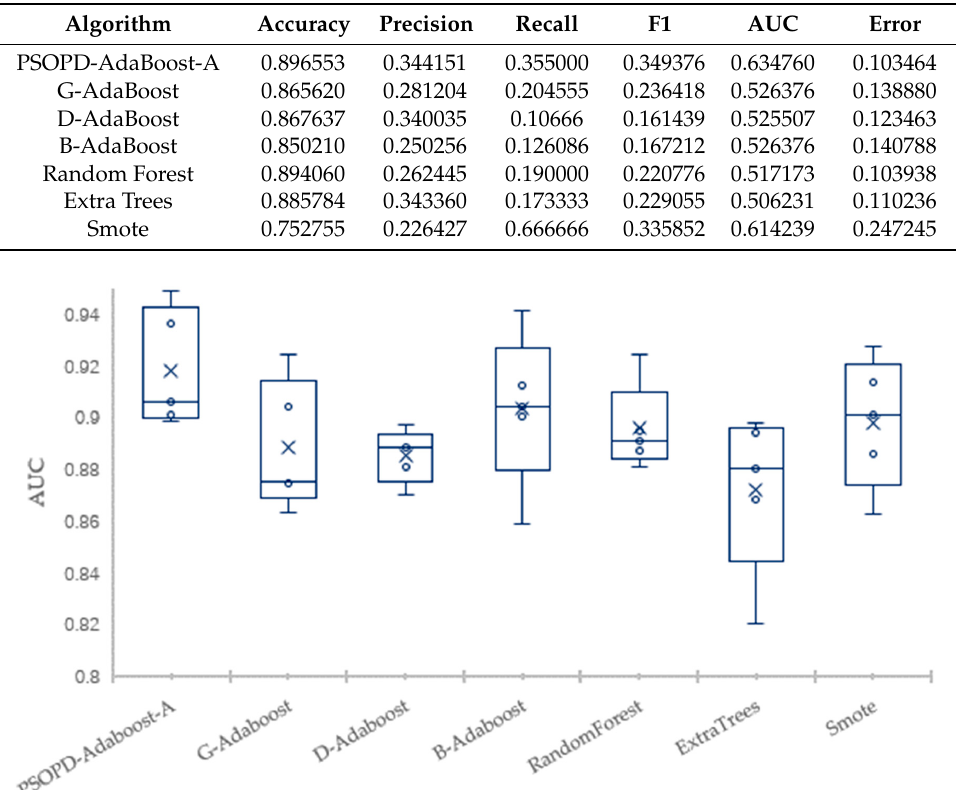
Table 6. Comparison of Classification Results on the CM1 Dataset. Table 3. Comparison of Classification Results on the Vehicle Dataset.